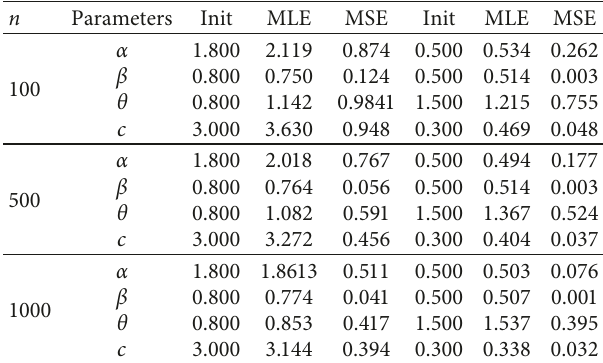
Table 3: MLE and MSE of NDWW distribution for set 1and set 2.